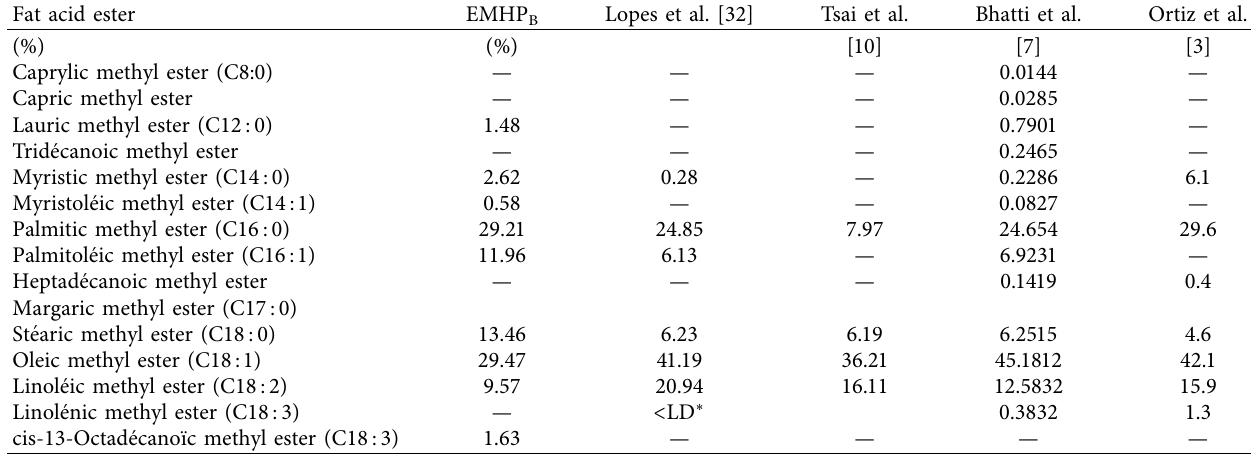
∗ Below the detection limit.